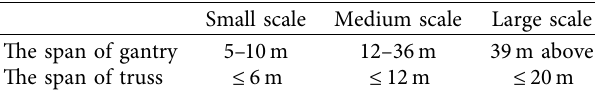
Figure 4: Frame structure. (a) Gantry structure [14] and (b) truss structure [6]. Table 1: Common dimensions of gantry and truss